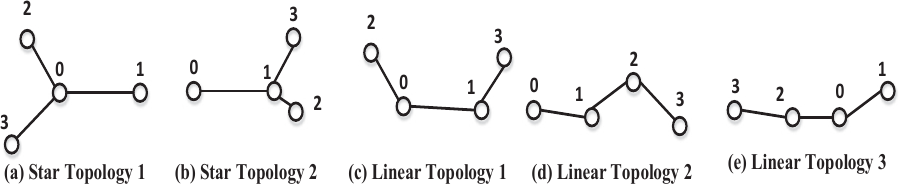
Fig. 3. Common location network